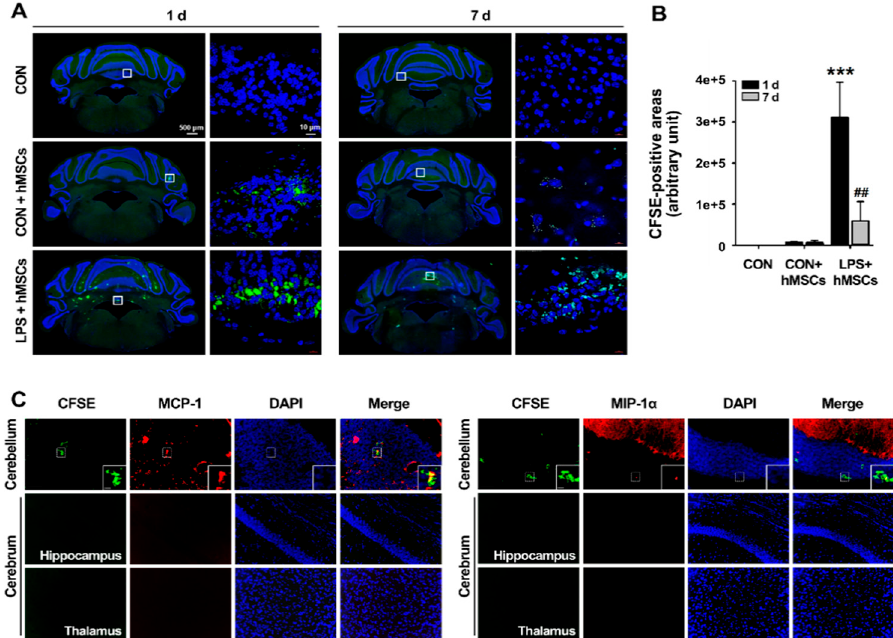
Figure 2. The distribution of transplanted hMSCs into LPS-exposed cerebellum after intrathecal injection. ( A ) Comparison of the overall distribution of CFSE-labeled hMSCs in the cerebellum between control and LPS-injected mice 1 day and 7 days after hMSC transplantation. Frozen cerebellum section shows double staining with the DAPI nuclear stain and CFSE (green) (Scale bar = 500 or 10 µ m). ( B ) Quantification showing the relative size of the CFSE-positive area of hMSCs at 1 day and 7 days post-hMSC transplantation. *** p < 0.001 vs. CON + hMSCs and ## p < 0.005 vs. LPS + hMSCs (1 day) (two-sided paired t-test; n = 4 per group). ( C ) Increased expression of MCP-1 and MIP-1 α in sites of inflammation is required for e ff ective hMSC migration after LPS exposure. Green indicates CFSE-labeled hMSCs and red indicates MCP-1 and MIP-1 α (Scale bar = 50 or 10 µ m). hMSCs, human mesenchymal stem cells; CFSE, Carboxyfluorescein Succinimidyl Ester; LPS, lipopolysaccharide; DAPI, 4 ′ ,6-diamidino-2-phenylindole; CON, Control.